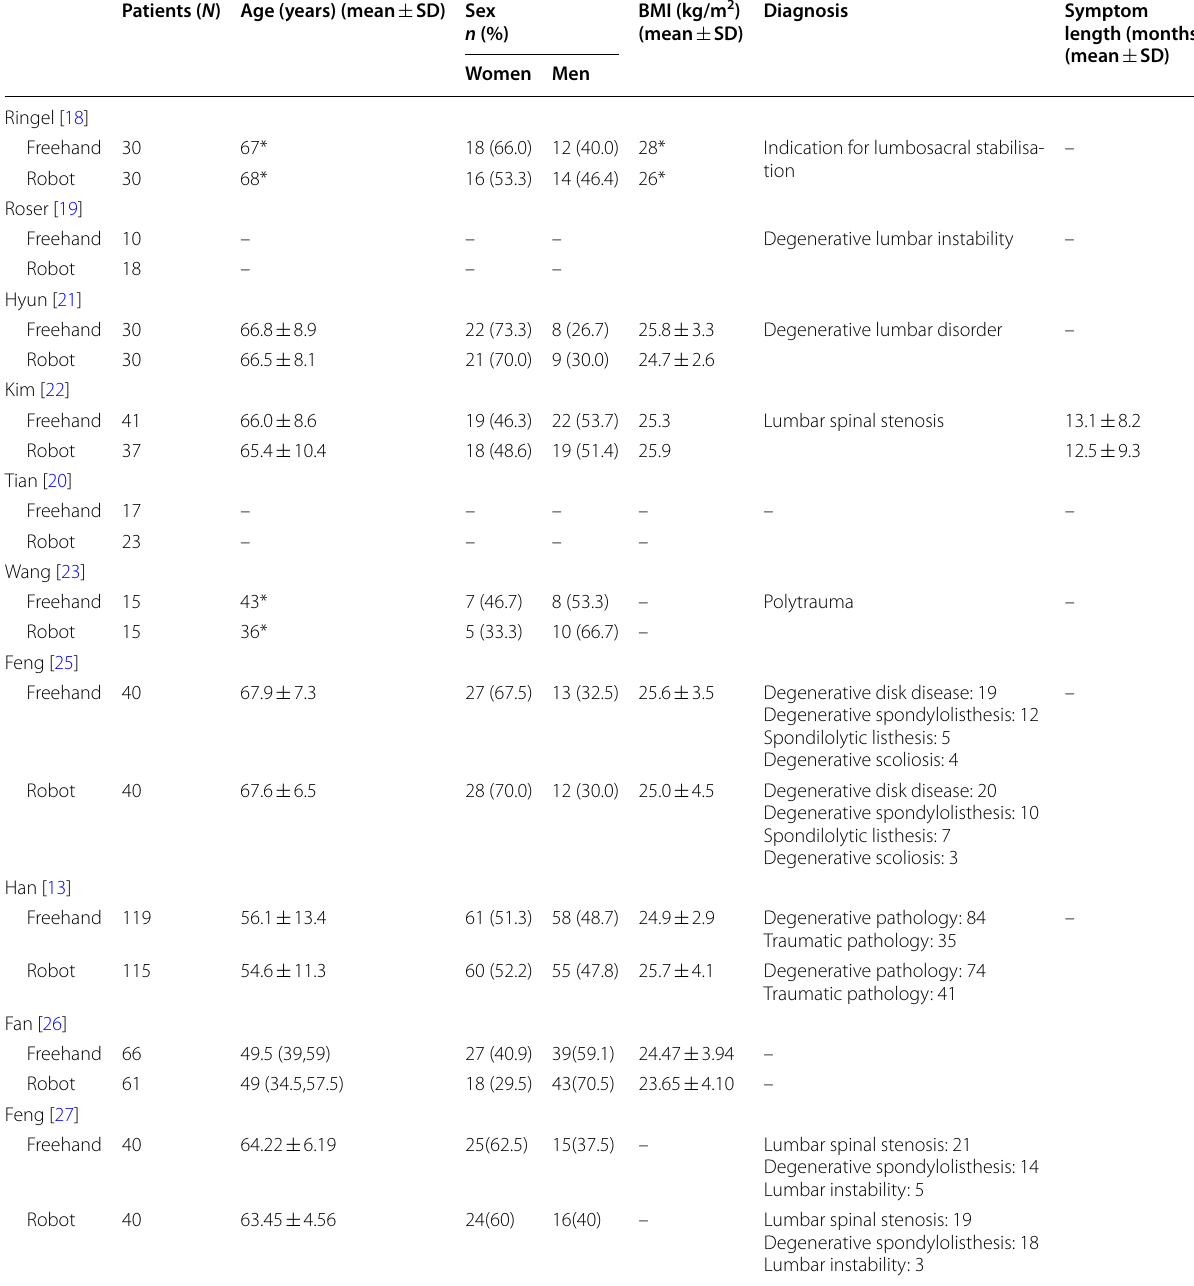
Table 2 Summary of patient